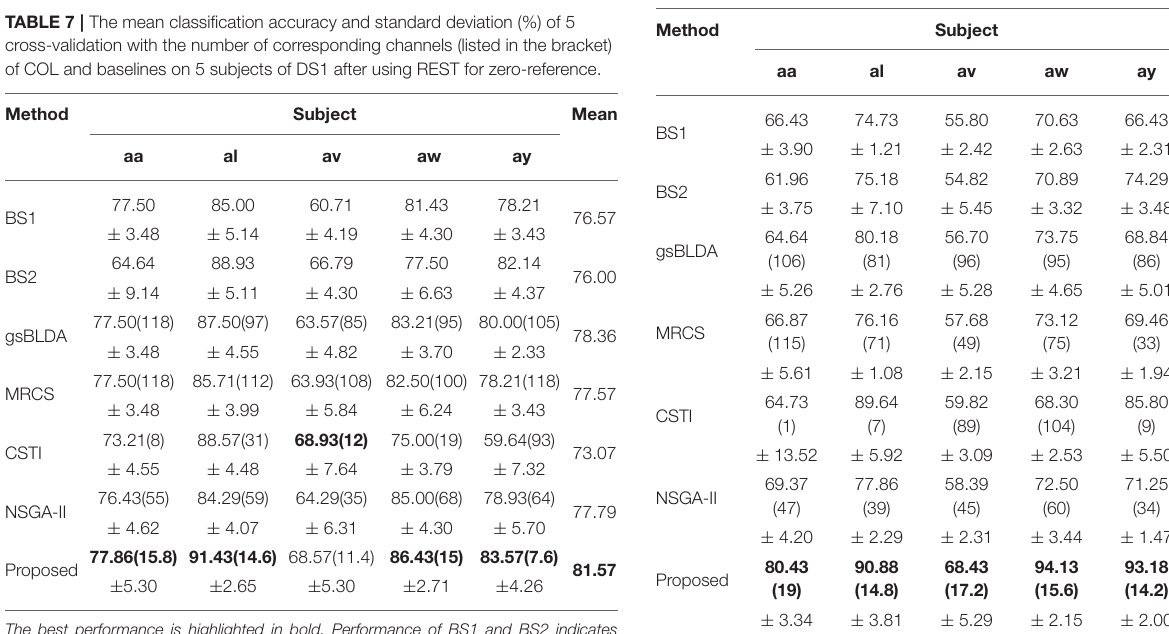
The best performance is highlighted in bold. Performance of BS1 and BS2 indicates classification accuracy with all channels and 3C channels, respectively. TABLE 9 | The mean classification accuracy and standard deviation (%) of 5 cross-validation (20% samples for training) with the number of corresponding channels (listed in the bracket) of COL and baselines on 5 subjects of